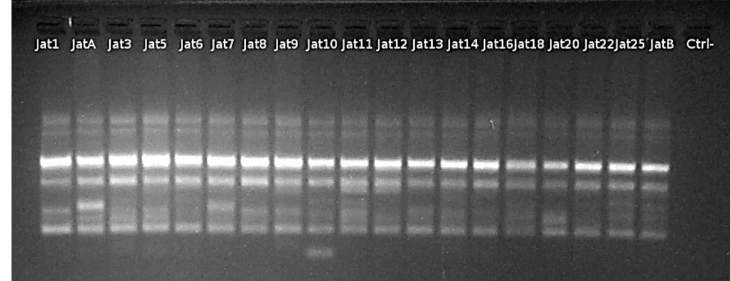
Figure 3. Amplification of genomic DNA of J. curcas obtained applying MG108 primer.